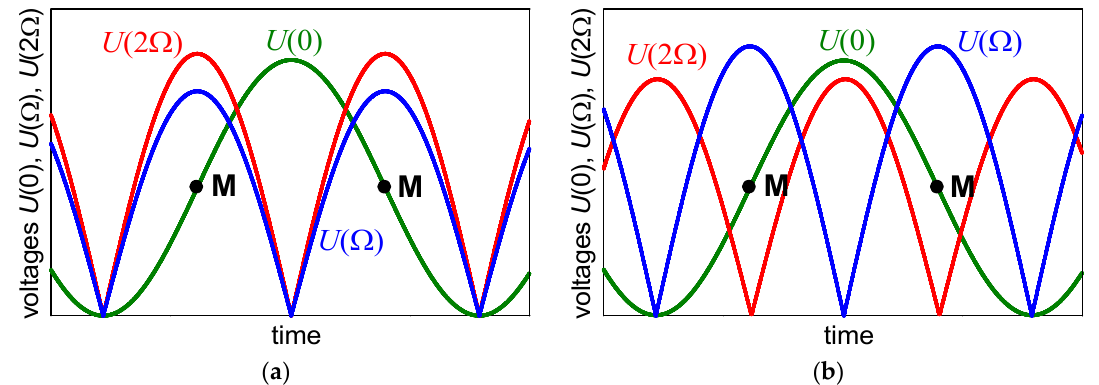
Figure 1. An example of theoretical time dependencies of the voltages U (0), U (Ω), and U (2Ω), as expected from Equations (8), (9), and (10), respectively. The phase shift Γ c increases linearly with time. Points M indicate the middle of the most sensitive linear part of the transmission characteristic of the modulator given by Equation (5), where Γ c = π / 2 + k π . ( a ) A case of well enough cut and oriented sample; ( b ) an example of false results that can be obtained in the case of an insufficiently precisely cut or poorly oriented sample in a noncentrosymmetric crystal.